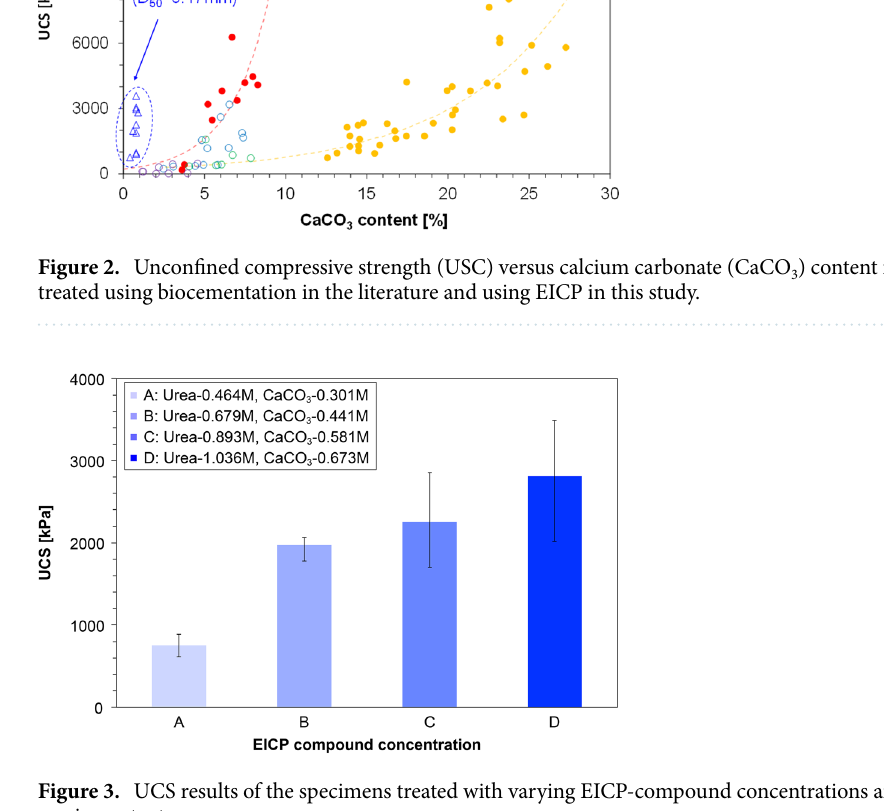
Figure 3. UCS results of the specimens treated with varying EICP-compound concentrations and constant casein